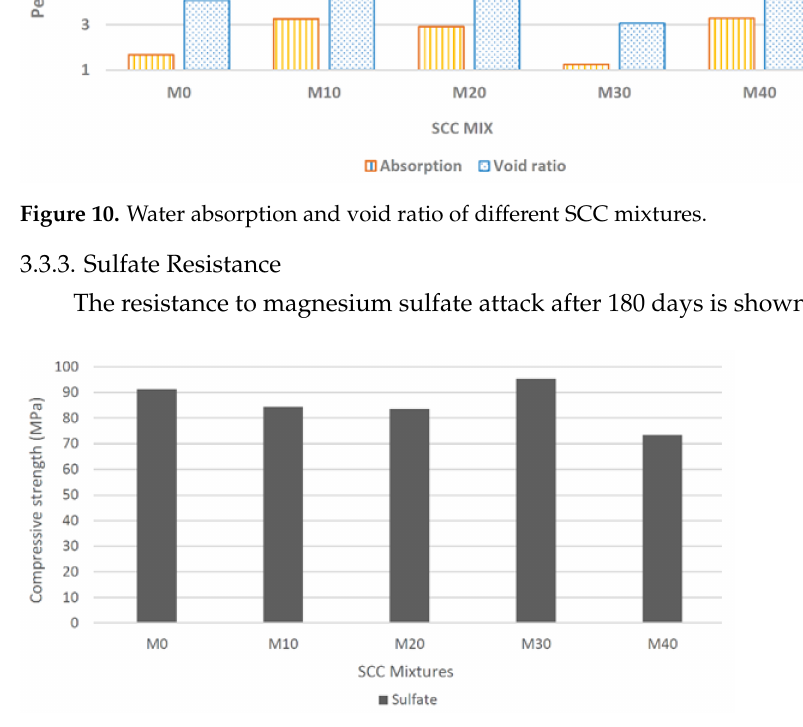
Figure 11. Compressive strength of SCC different mixtures after sulfate